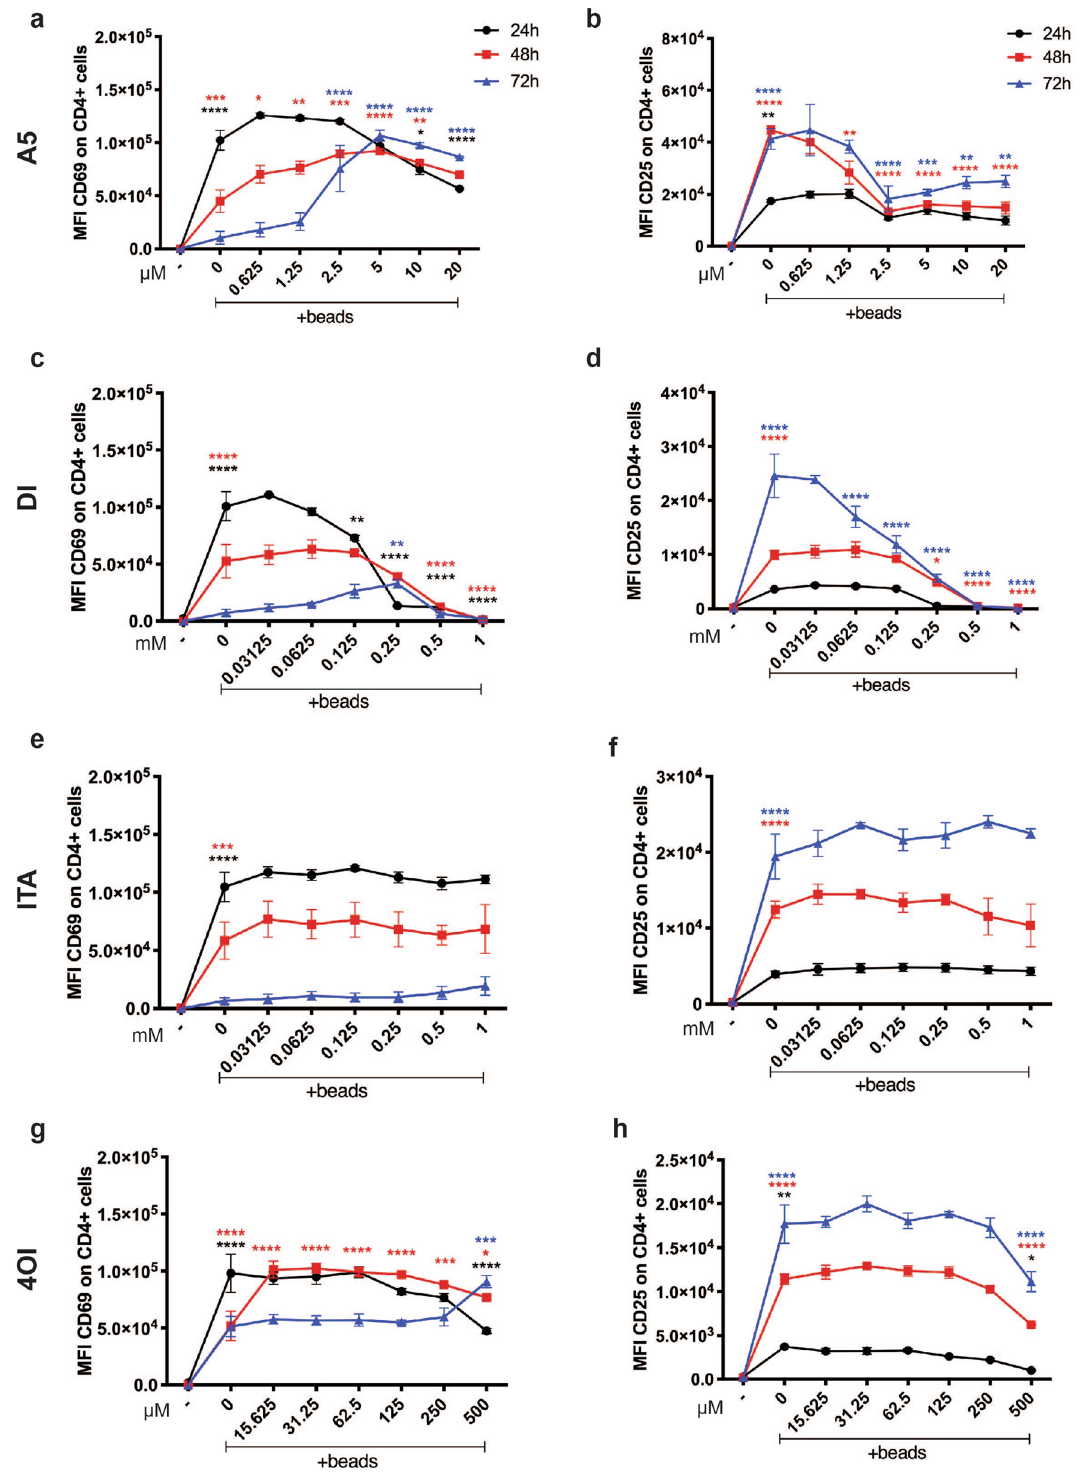
Figure 3. Flow cytometry analysis of CD4 + T cells surface activation marker CD25 and CD69. Isolated human CD4 + T cells were exposed to ( a , b ) A5, ( c , d ) DI ( e , f ), ITA, and ( g , h ), 4OI, in a concentration gradient and analysed after 24 h (black), 48 h (red), and 72 h (blue) by flow cytometry, gating on live cells. Mean Fluorescence Intensity (MFI) ± s.e.m. are shown for CD25 and CD69 expression levels (n = 3 independent experiments). P values are calculated using two-ay ANOVA. *P < 0.05, **P < 0.01, ***P < 0.001, ****P <